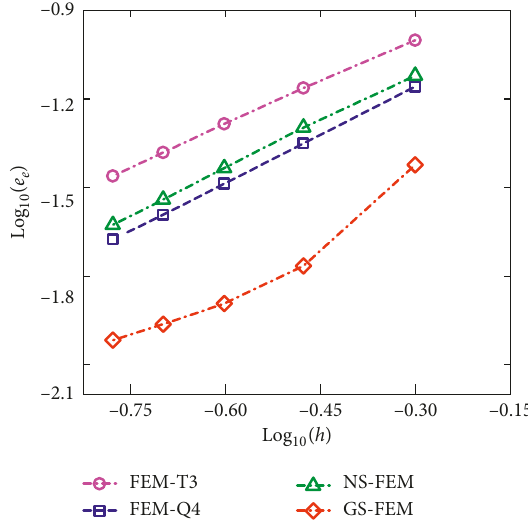
Figure 21: Convergence rate of energy error norm.